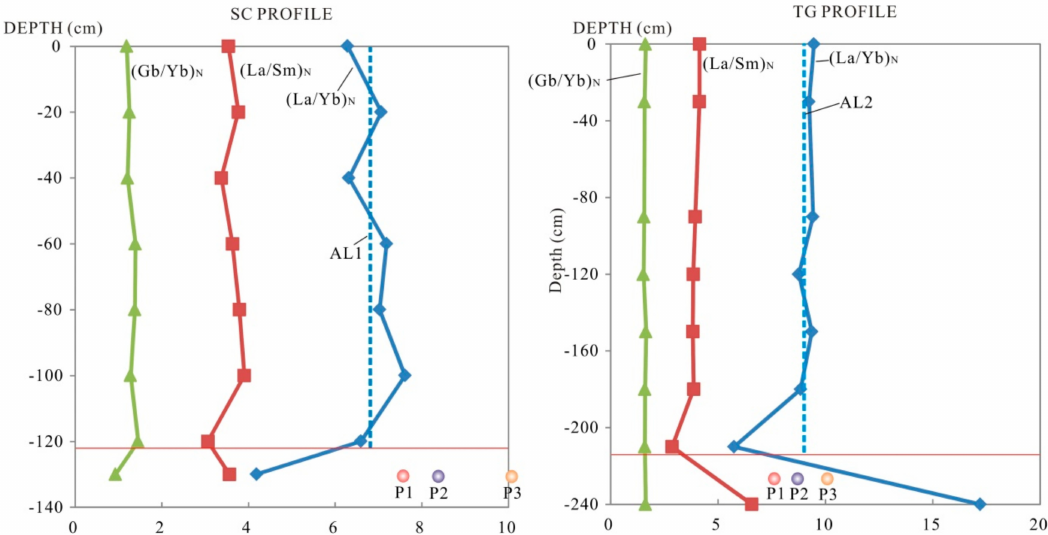
Figure 4. The variation of (La / Yb) N , (La / Sm) N , and (Gb / Yb) N in SC and TG profiles. AL1, average line of (La / Yb) N from RSI to the top soil in SC profile; AL2, average line of (La / Yb) N from RSI to top soil in TG profile; P1, average point of (La / Yb) N in granite; P2, average point of (La / Yb) N in gneiss; P3, average point of (La / Yb) N in sandstone. The average data of (La / Yb) N in granite, gneiss, and sandstone were cited from Yang et al.